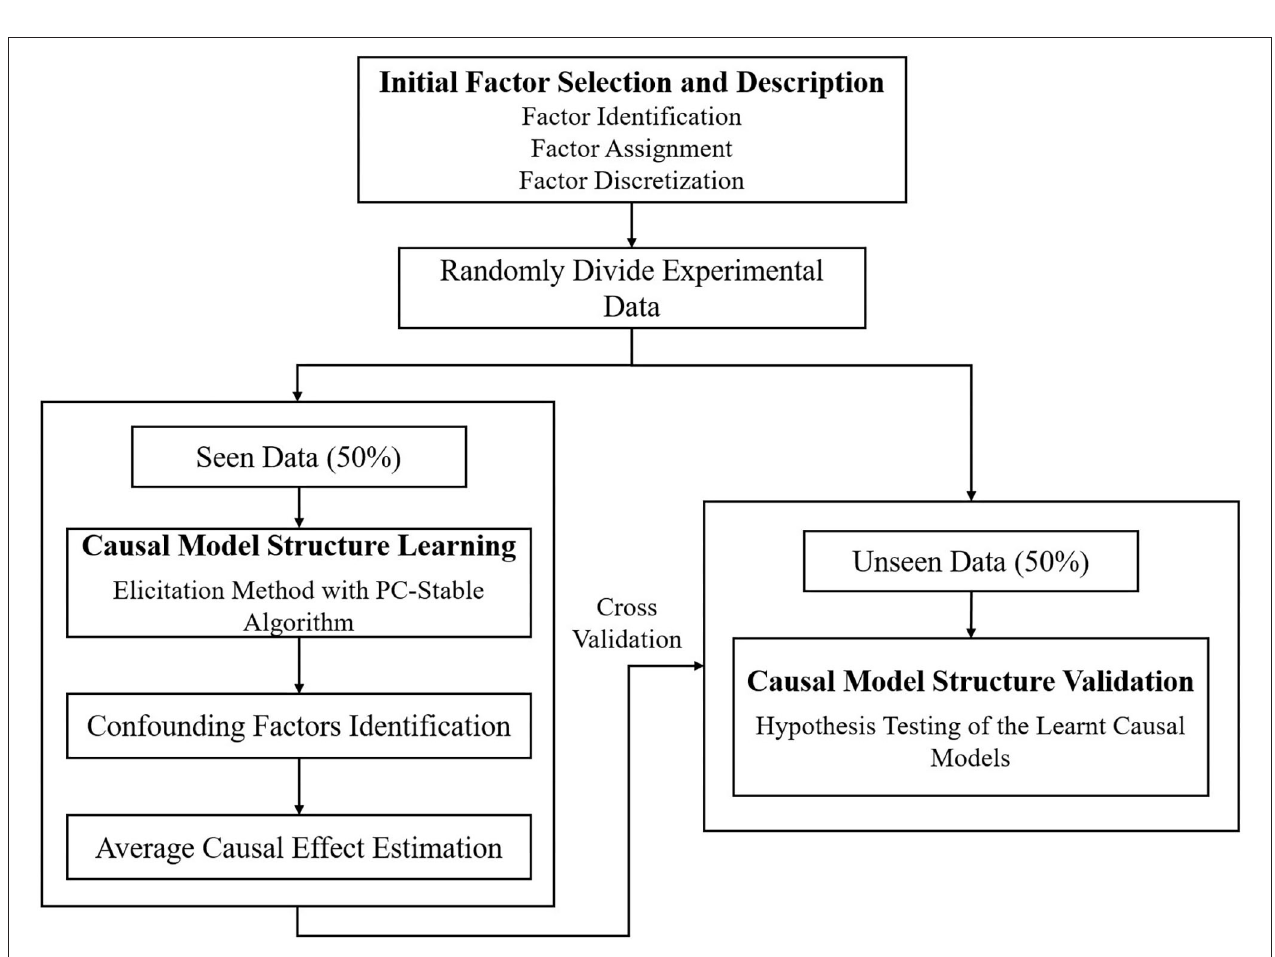
FIGURE 3 | Overview of the